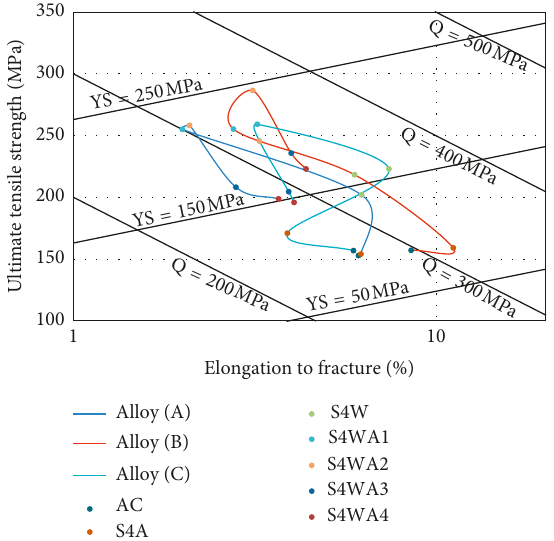
Figure 11: Quality chart showing relationship between UTS and % El for the A B and C alloys in the as-cast and six heat treatment conditions with SHT for 4h.